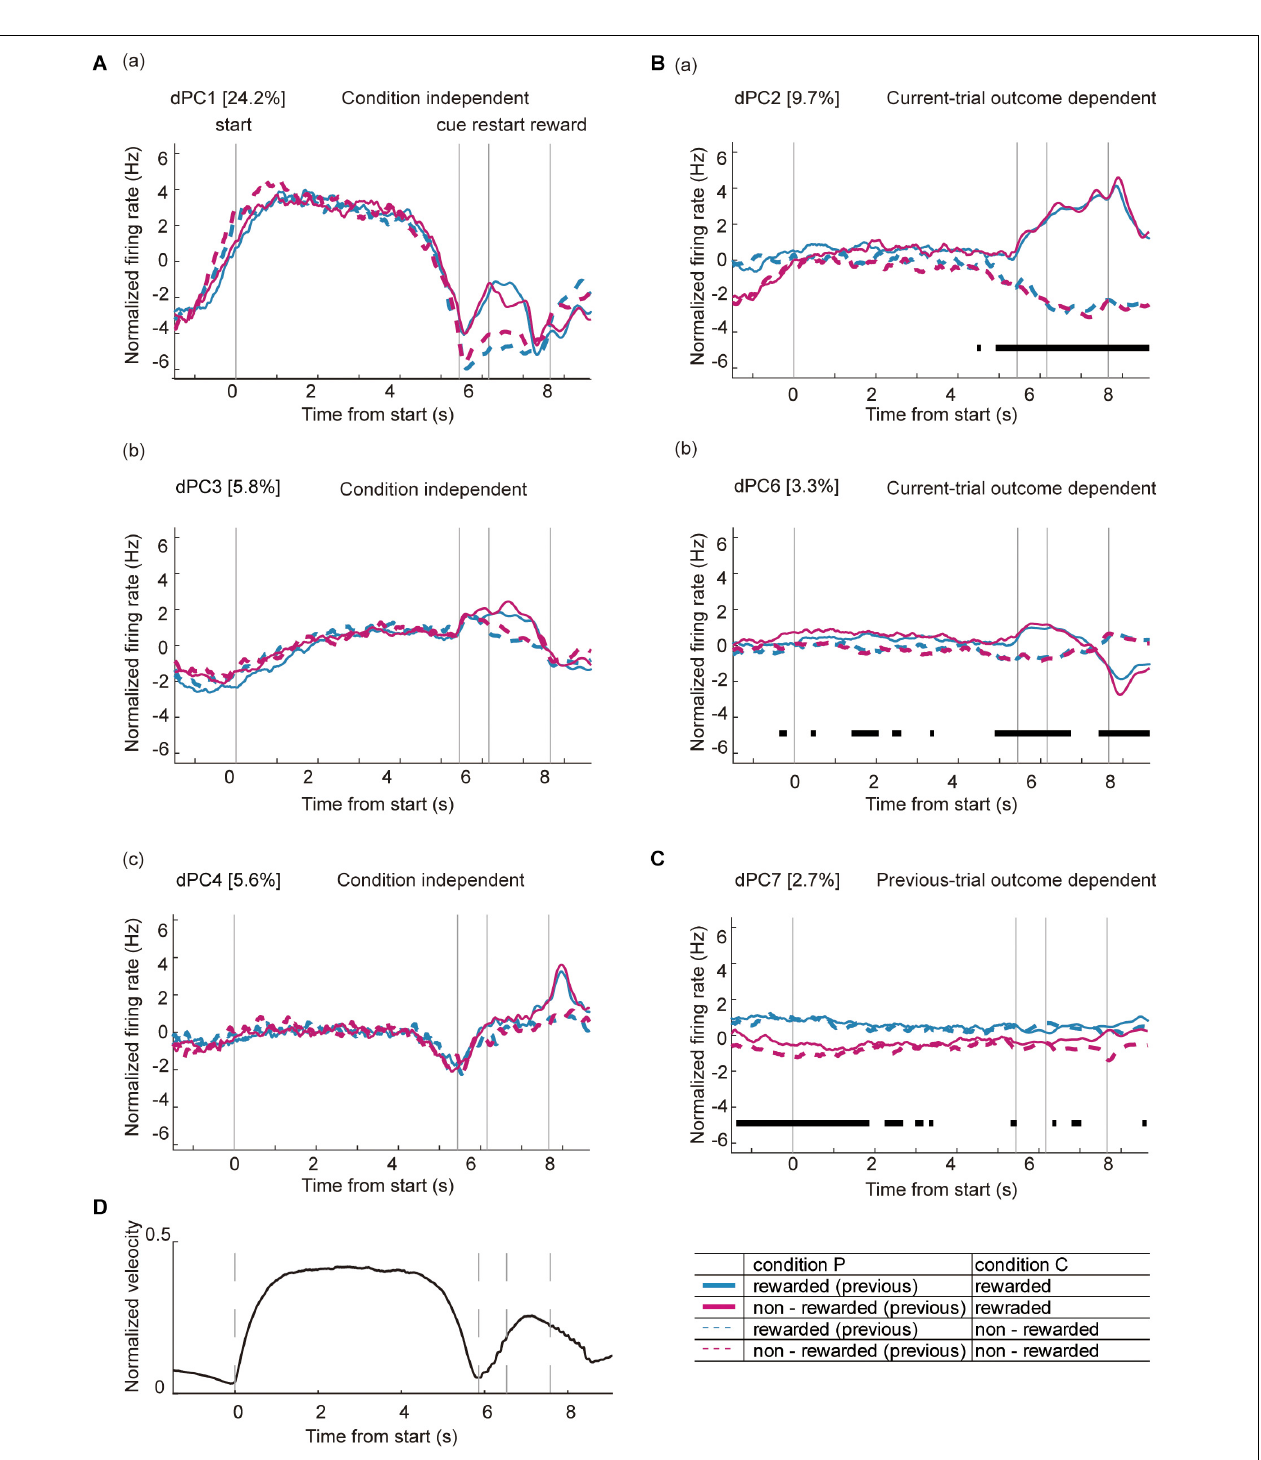
FIGURE 10 | Demixed principal component analysis of ACC neurons during the locomotor task. Time course of dPCs during the locomotor task: (A) condition-independent components, (B) components dependent on the behavioral outcome of the current trial (current-trial-outcome-dependent), and (C) components dependent on the behavioral outcome of the previous trial (previous-trial-outcome-dependent). Dashed lines indicate the timing of each key task event (start, cue, and reward). Variance of each dPCs are shown as percentage. Thick black lines in panels (B,C) indicate that the timing of the respective condition (rewarded or non-rewarded) can be reliably extracted from the single-trial activity. (D) Averaged velocity of locomotion during a single trial in all of the animals. The locomotion velocity in all trials were averaged, normalized, and time-stretched in a similar way to the dPCA analysis of neurons.